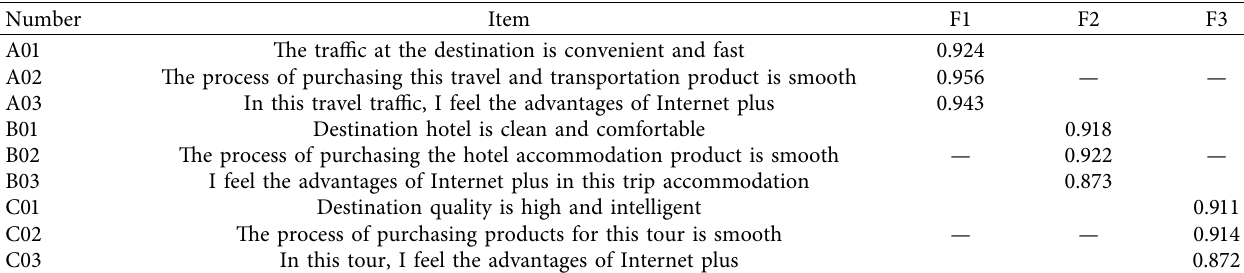
Table 2: Factor analysis of public tourism services.